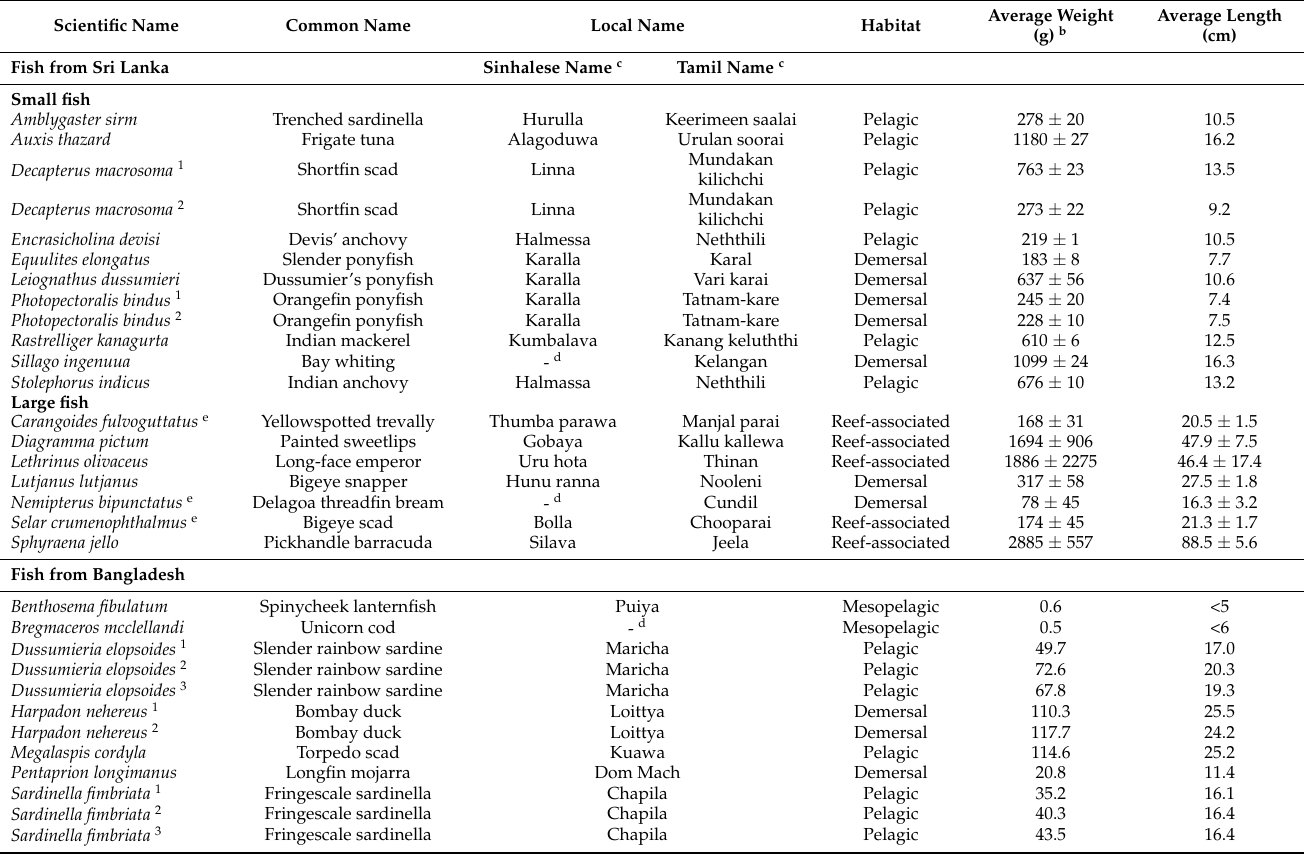
Table 3. Identification details and physical parameters of fish species sampled from Sri Lanka and Bangladesh a